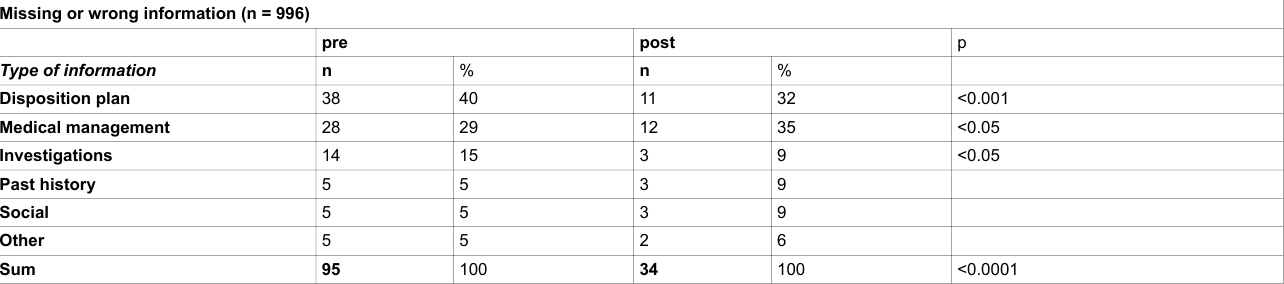
Table 1 Missing or wrong information given in handovers as judged by senior ED physician in the post-handover survey. Missing or wrong information (n =